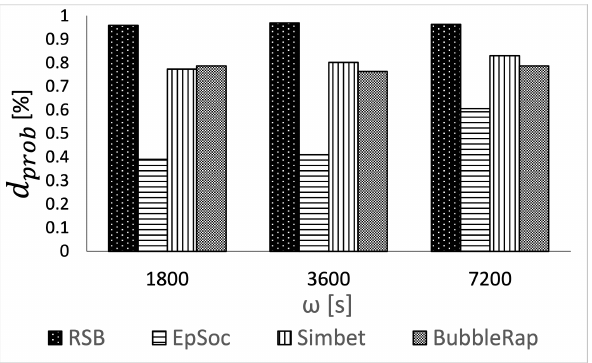
Figure 7. Delivery probability ( d prob ) as a function of the message generation interval ( ω ).